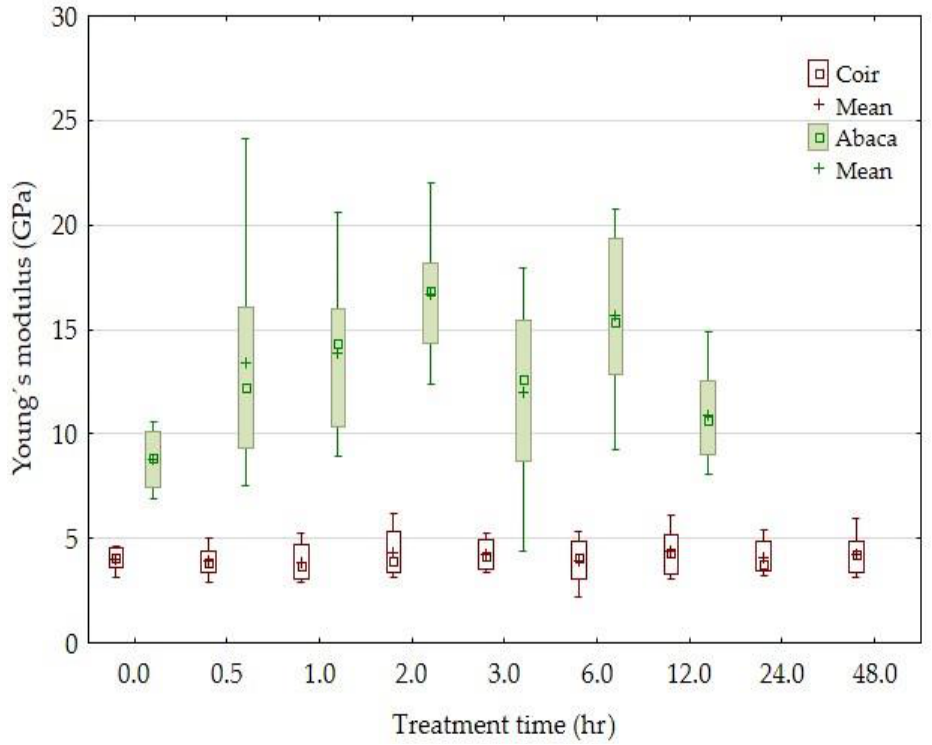
Figure 4. The dependence of the Young’s modulus of the coir and abaca fibers on the time of treatment in a 5% solution of NaOH.